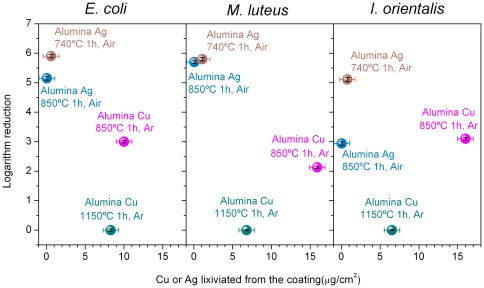
Logarithm of reduction of E. coli, M. luteus and I. orientalis for the coatings versus the total of silver or copper lixiviated per area unit.